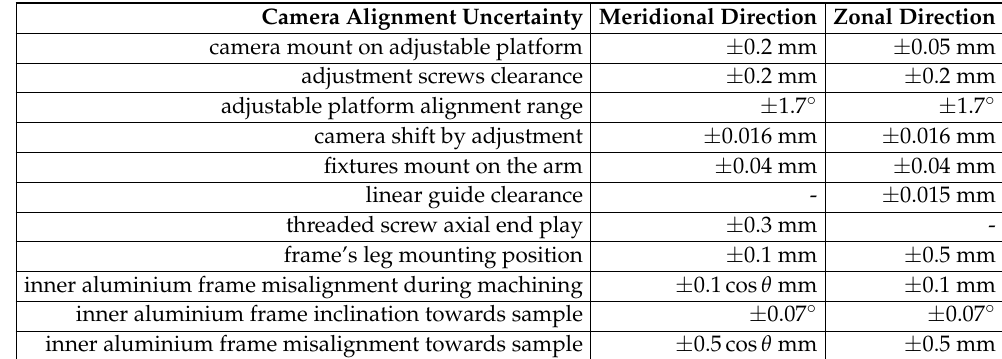
Table A2. The uncertainty specification of camera